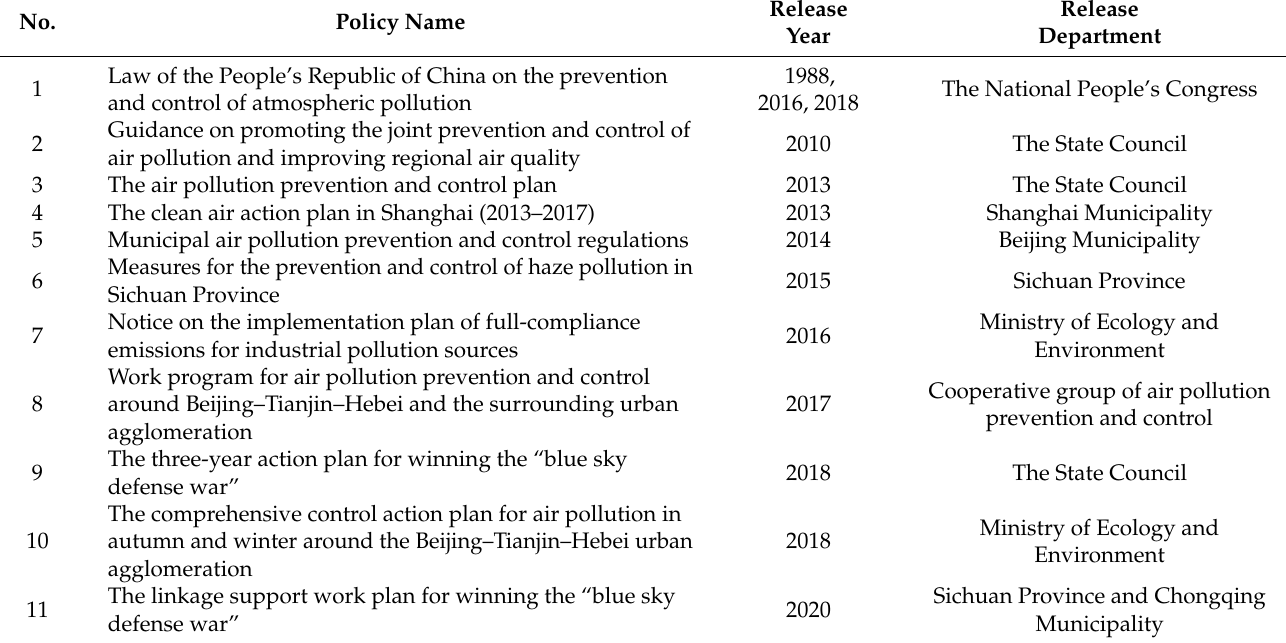
Table 2. Representative documents and statistics on China’s policies in relation to haze pollution prevention and control.